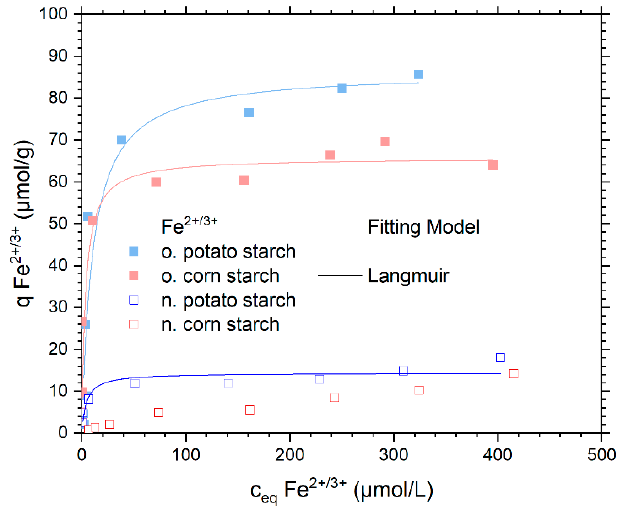
Figure 6. Adsorption isotherms capacity for Fe 2+/3+ from FeSO 4 solution and the respective Langmuir isotherm model fits. The Langmuir and the Dubinin–Radushkevich fitting models were presented in Figure S11. With n. potato starch is shown in blue, n. corn starch in red, o. corn starch in pink and o. potato starch in light blue.